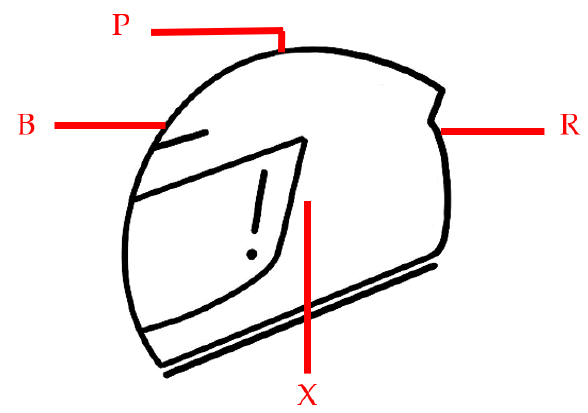
Figure 1. Impact positions on the helmet structure.